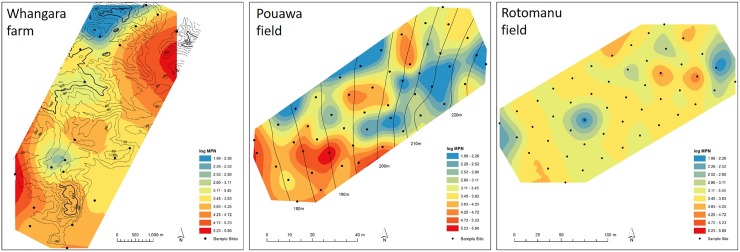
Spatial variation in Rhizobium leguminosarum bv. trifolii population size, (most probable number) based on nodule formation on Trifolium repens cv. Tribute.Black dots represent sampling spots based on GPS-marked points. Contour lines for Whangara and Pouawa are given; the field at Rotomanu had flat topography. MPN variation between samples was assessed using the RBK method in ARC-GIS.